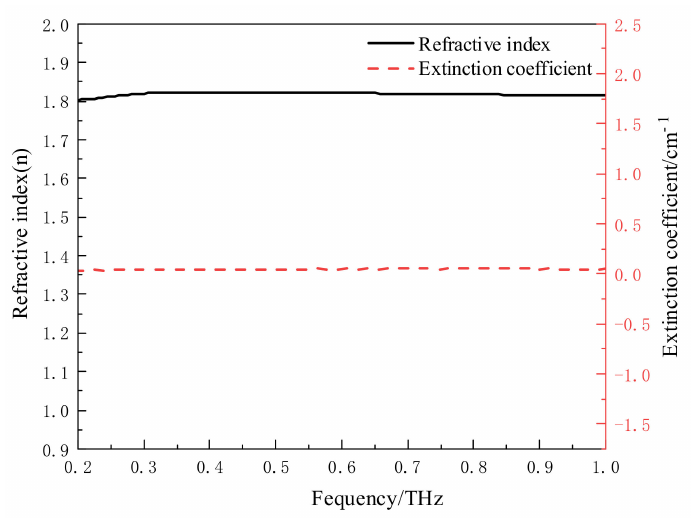
Figure 3. Refractive index and extinction coefficient of silicone adhesive in terahertz